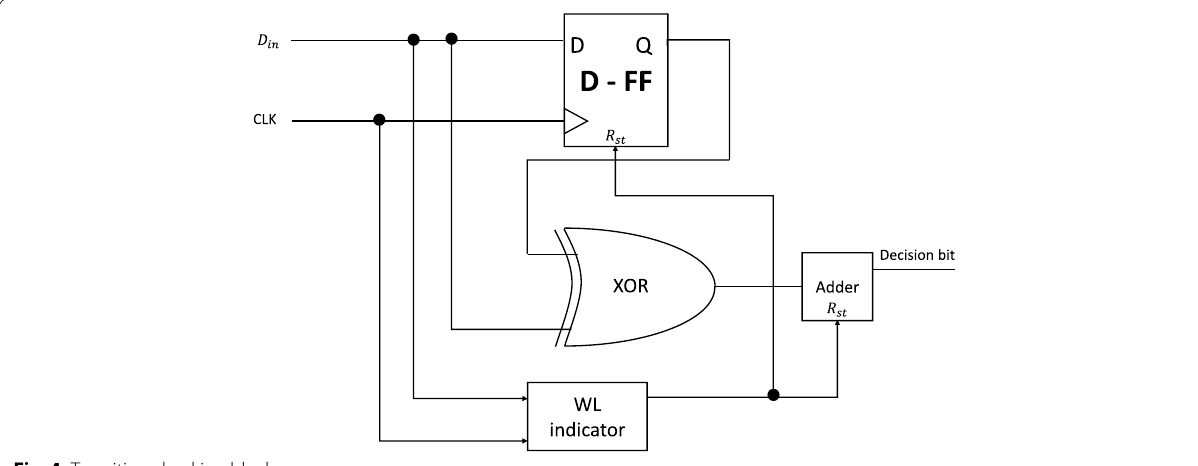
Fig. 4 Transition checking